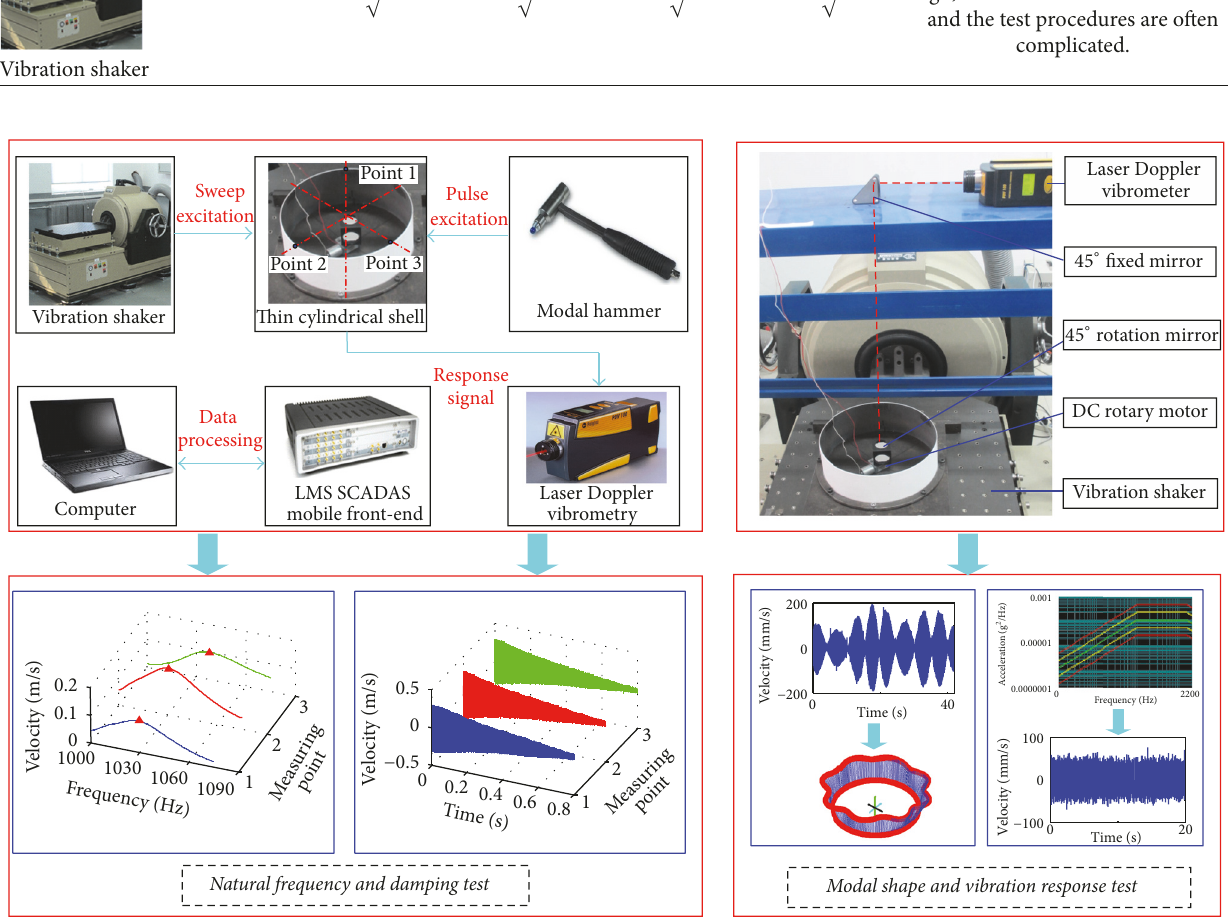
Figure 4: The schematic of test system of vibration characteristics of TCS with or without hard